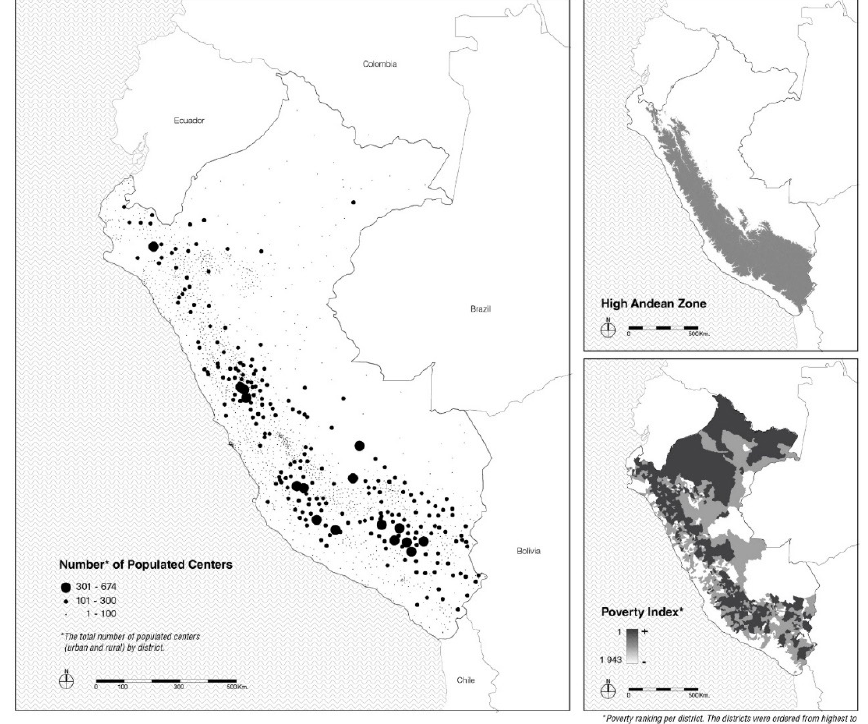
Figure 2. The concentration of populated centers and the incidence of poverty